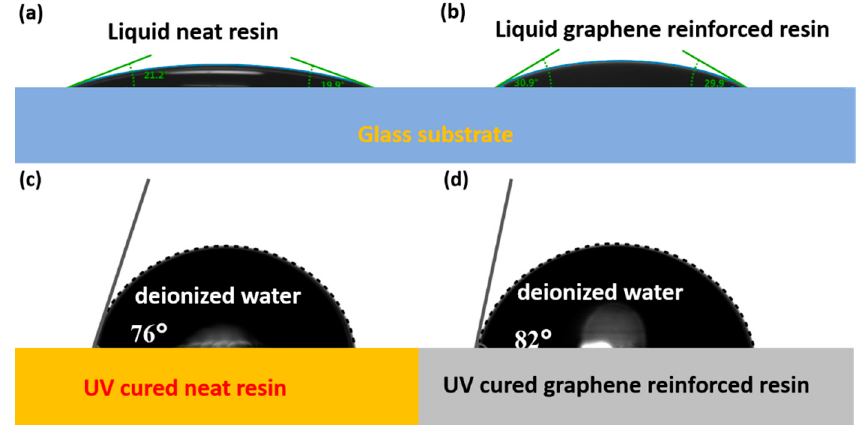
Figure 4. Contact angle images of ( a ) the liquid neat resin (around 20 ◦ ) and ( b ) liquid 0.5 wt.% graphene-reinforced resin (around 30 ◦ ) on a glass substrate. Water contact angle images of UV-cured ( c ) neat resin and ( d ) 0.5 wt.% graphene-reinforced resin.